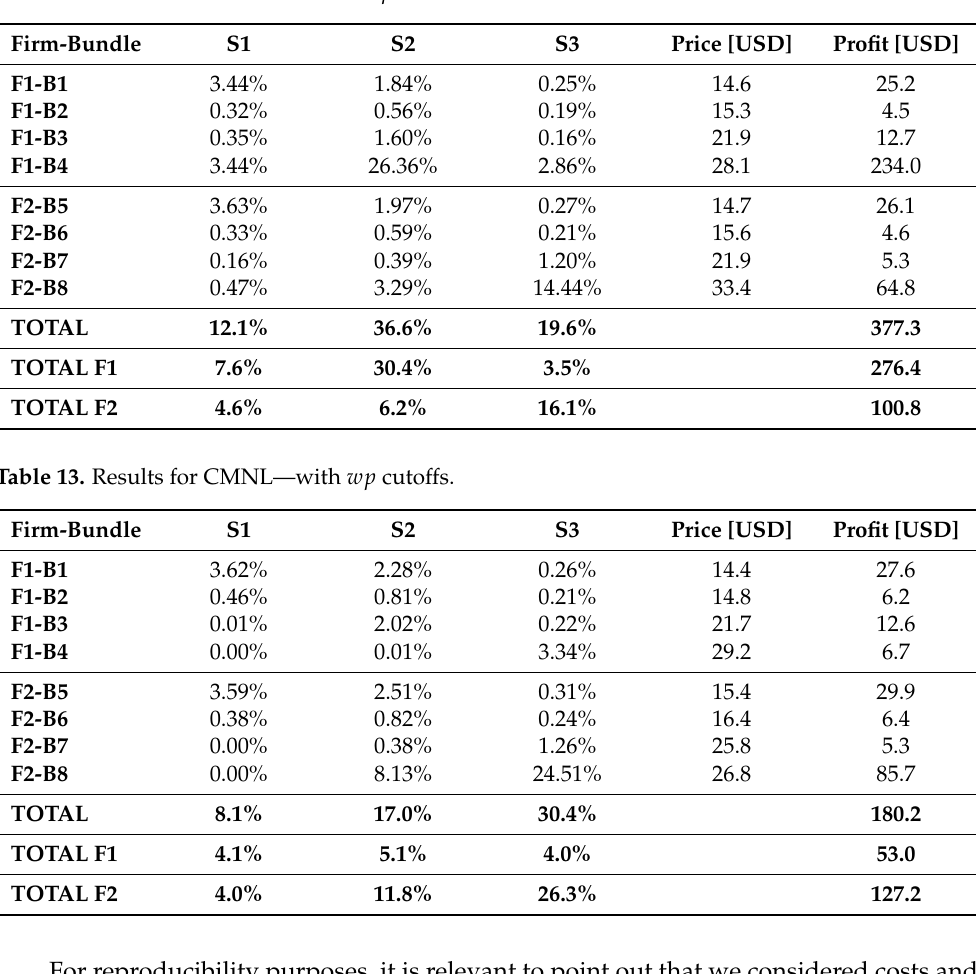
Table 12. Results for MNL—without wp cutoffs.